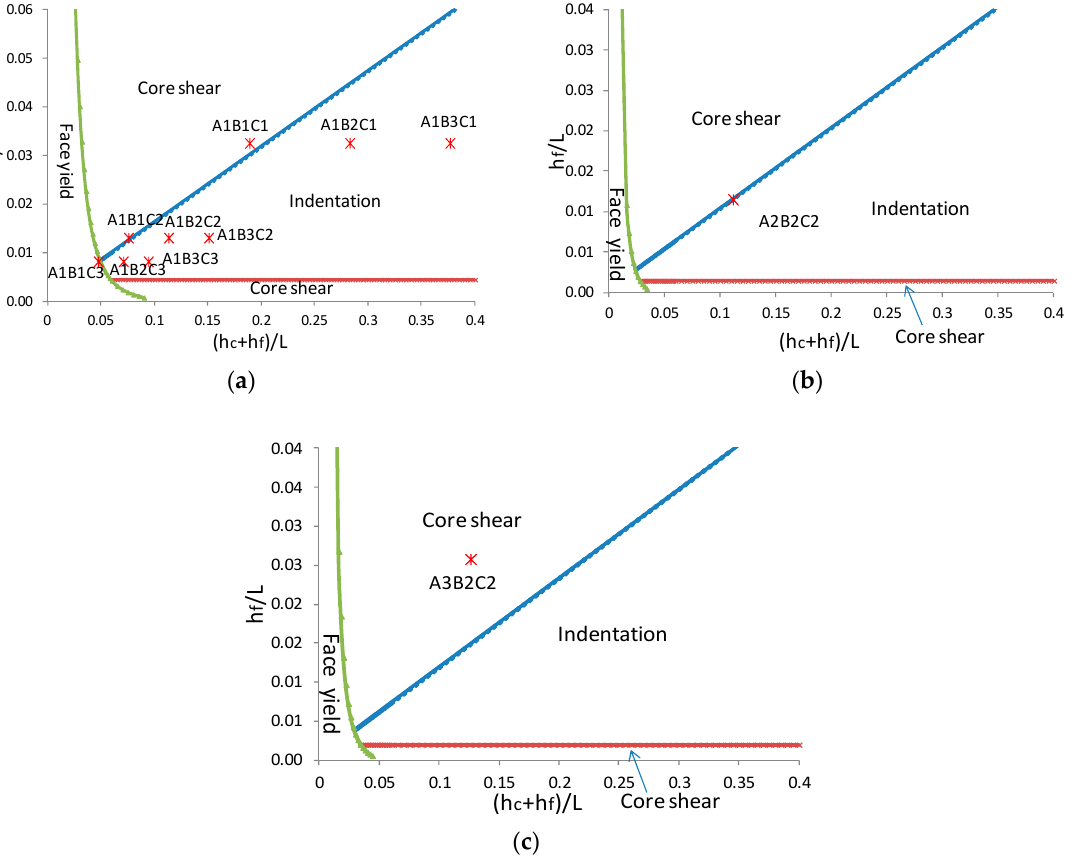
Figure 11. Failure map based on construction parameters: ( a ) sandwich beam with 3.175 mm MDF surface, ( b ) sandwich beam with 3.175 mm PLY surface, ( c ) sandwich beam with 6.35 mm PLY surface.